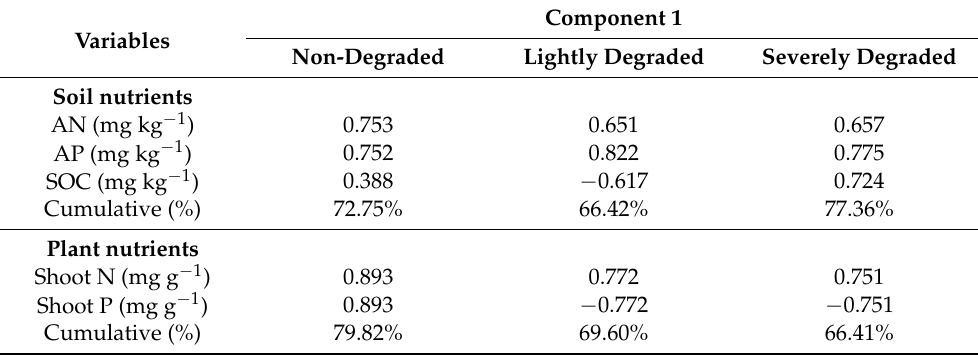
Table 4. Partial correlation coefficients of principal components analysis (PCA) of variables in categories of plant nutrients and soil nutrients in soil degradation